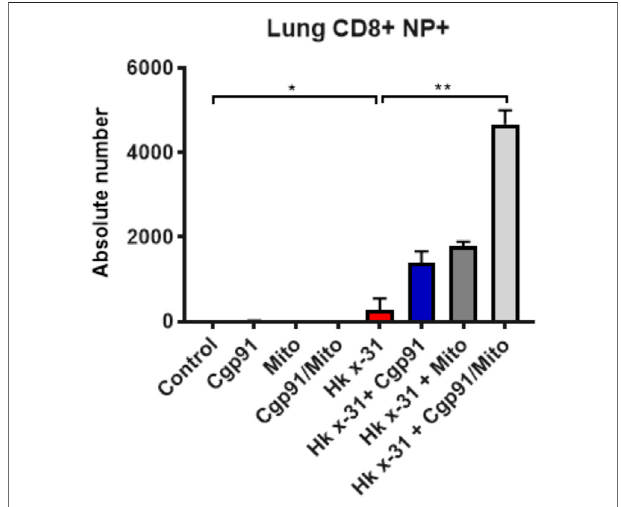
FIGURE 5 | Combination therapy elevates virus-speci fi c T cells in the lung. C57Bl/6J mice were treated once daily via intranasal administration of Cgp91ds-TAT (0.2 mg/kg) and mitoTEMPO (100 µg) in combination or individually over a 2 days period 1 day pi with Hkx31 (10 4 PFUs) or PBS for assessment at day 6 pi. Cells isolated from the lung tissue were collected forimmunecelldifferentiationthatwasassesedusing fl owcytometricanalysis. Virus-speci fi c CD8 + T cells were gated as CD8+NP366+. Data are expressed asmean±SEM(Control, n =4;Cgp91, n =4;mitoTEMPO n =4;Cgp91/Mito, n = 4; Hkx31, n = 5 Hkx31 + Cgp91, n = 6; Hkx31 + Mito, n = 6; Hkx31 + Cgp91/Mito, n = 6). Statistical analysis were conducted using one-way ANOVA test followed by Tukey ’ s post hoc test for multiple comparison test. Statistical signi fi cance was taken where p < 0.05 (* denotes p < 0.05 and ** p <